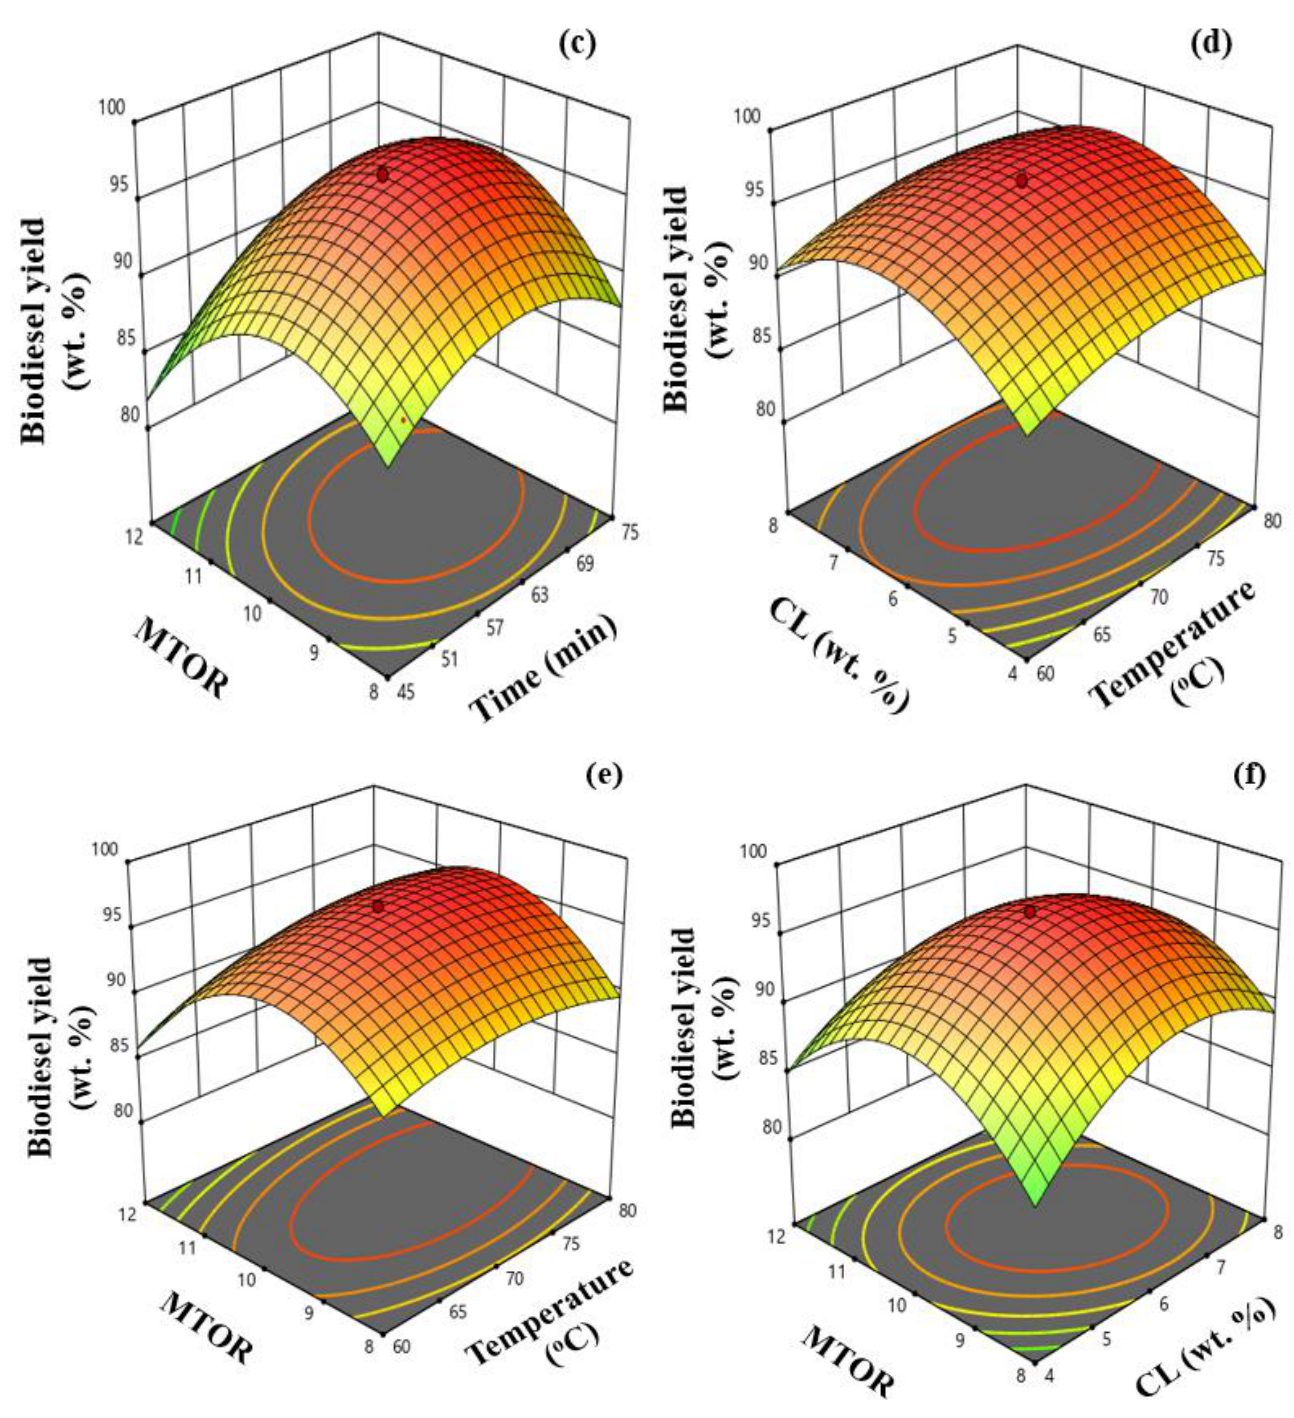
Figure 12. Surface plots of biodiesel yield with respect to MTOR, CL, time, and temperature (a −f